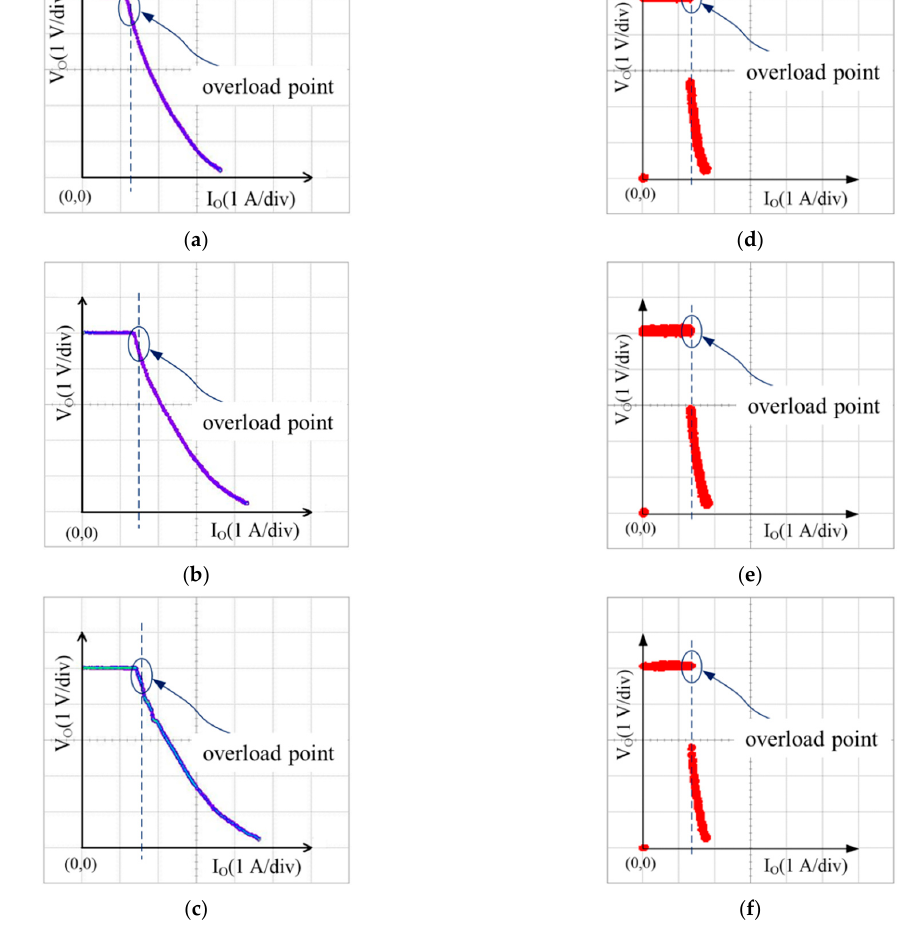
Figure 9. V-I curves obtained by using the traditional peak current detection circuit with input voltage ( a ) 17V, ( b ) 18V, and ( c ) 34V, and by using the proposed FBC method with input voltage ( d ) 17V, ( e ) 18V, and ( f ) 34V.